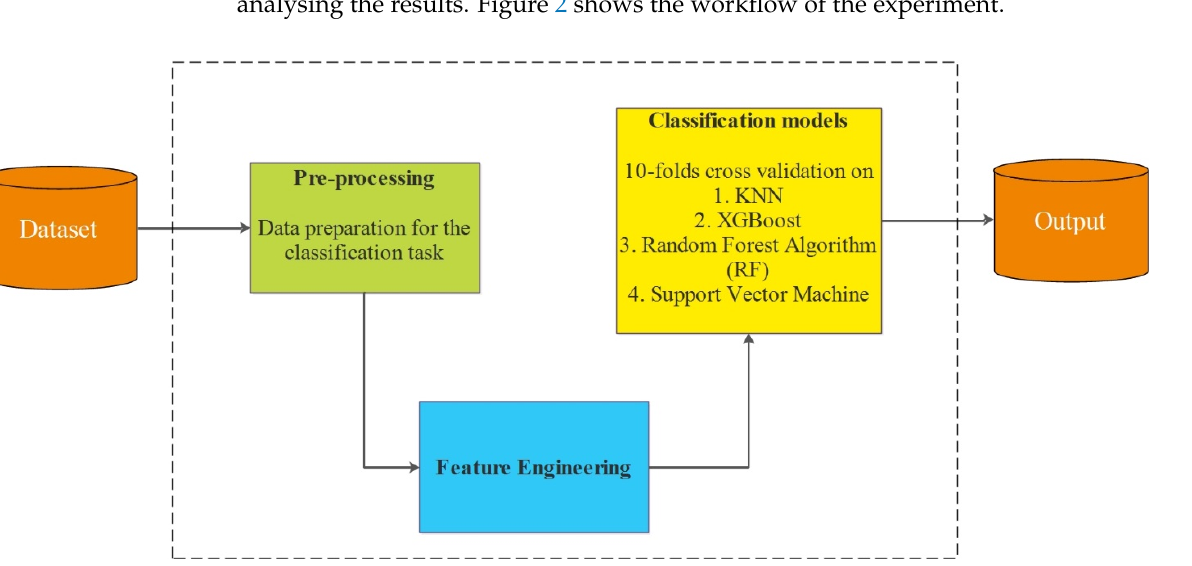
Figure 2. Schematic illustration of the carried-out procedure. The first step is to select the data and find the various and influential characteristics of human actors that align with the objectives of the subject and should be used as input in the classification process. The 11 examined features are described in Table